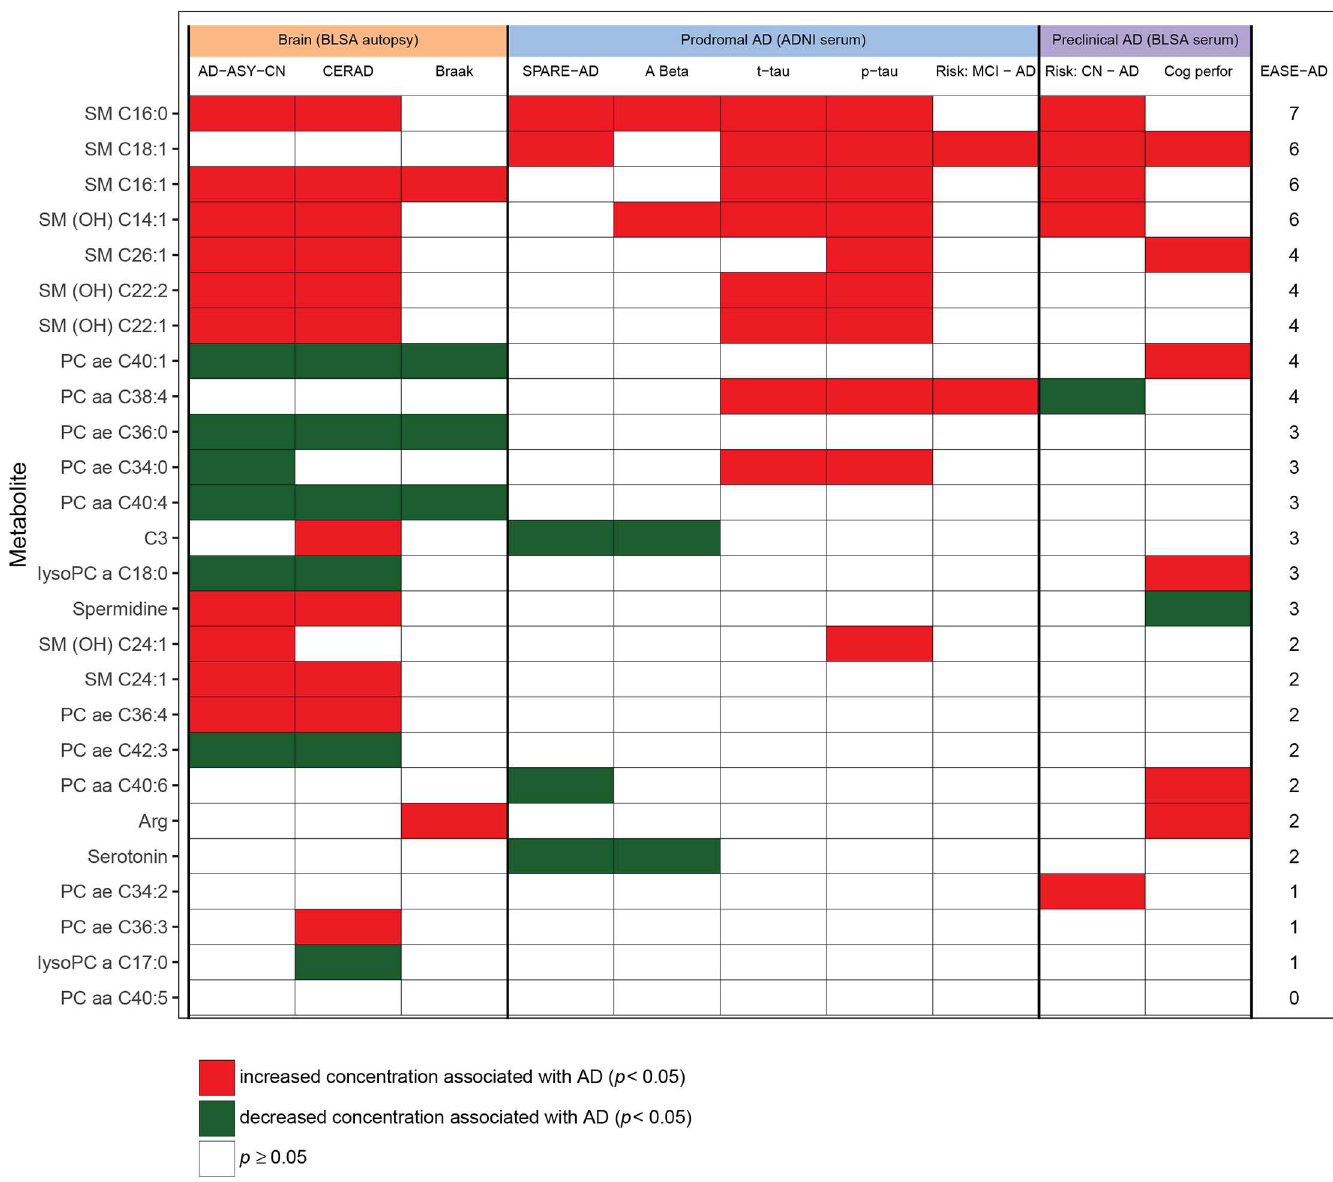
Fig 4. Heat map summarizing associations between metabolites and AD endophenotypes. Meanings of column headings: AD-ASY-CN, association between brain tissue metabolite concentration and clinical diagnosis of AD; CERAD, association between brain tissue metabolite concentration and plaques measured by CERAD score; Braak, association between brain tissue metabolite concentration and neurofibrillary tangle burden measured by Braak score; SPARE-AD, association between blood tissue metabolite concentration in ADNI and SPARE-AD score; A Beta, association between blood tissue metabolite concentration in ADNI and CSF A β 1–42 ; t- tau, association between blood tissue metabolite concentration in ADNI and CSF (t-tau); p-tau, association between blood tissue metabolite concentration in ADNI and CSF (p-tau); Cog perfor, association between blood tissue metabolite concentration and cognitive performance prior to AD onset; EASE-AD, sum of significant associations across AD-related endophenotypes. ADNI Cox: association between blood tissue metabolite concentration and risk of incident AD in ADNI among MCI individuals. BLSA Cox: association between blood tissue metabolite concentration and risk of incident AD/MCI in BLSA among cognitively normal individuals. A β 1–42 , amyloid beta 1–42; AD, Alzheimer disease; ADNI, Alzheimer’s Disease Neuroimaging Initiative; ASY, asymptomatic Alzheimer’s disease; BLSA, Baltimore Longitudinal Study of Aging; CERAD, Consortium to Establish a Registry for Alzheimer’s Disease; CN, control; CSF, cerebrospinal fluid; EASE-AD, Endophenotype Association Score in Early Alzheimer’s disease; MCI, mild cognitive impairment; OH, hydroxyl; p-tau, phosphorylated tau; PC, phosphatidylcholine; SM, sphingomyelin; SPARE-AD, Spatial Pattern of Abnormality for Recognition of Early Alzheimer’s disease; t-tau, total tau.